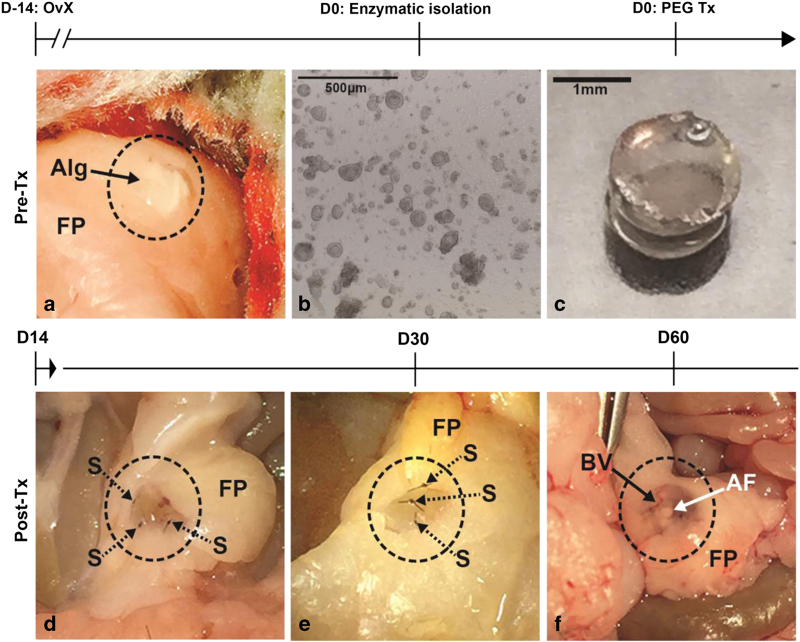
The timeline for inducing premature ovarian failure and grafting artificial ovarian tissue: (a) a bilateral ovariectomy (OvX) was performed to induce premature ovarian failure in mice. In order to maintain the space within the bursa after OvX, inert alginate beads (black arrow) were inserted to prevent the collapse and adhesion. (b) The early-stage follicles were enzymatically isolated from 6- or 7-day-old female mice. (c) Follicles were encapsulated in PEG hydrogels. One PEG grafts with enzymatically isolated follicles was transplanted (Tx) into each ovarian bursa, two implants per mouse. PEG grafts were retrieved (d) 14 (nmice=11), (e) 30 (nmice=6) and (f) 60 (nmice=6) days after Tx (FP, fat pad; S, sutures (dotted arrows); BV, blood vessels; AF, antral follicle).